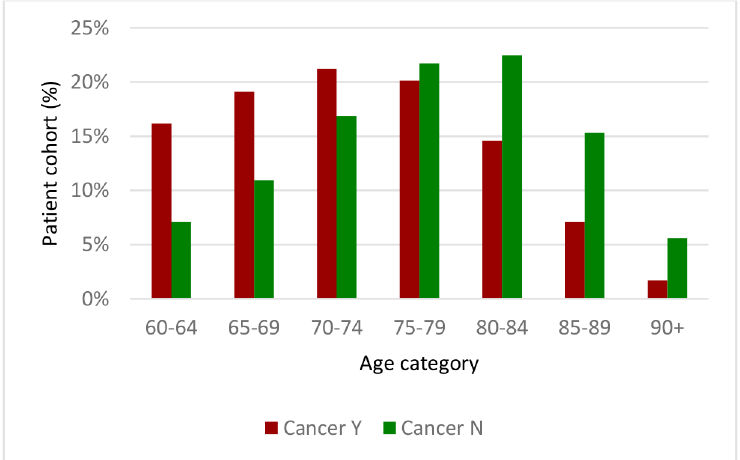
Supplementary Figure 2: Percentage of cancer patients with cancer as their main cause of death (Cancer = Y) and “other” main death diagnosis (Cancer = N) by